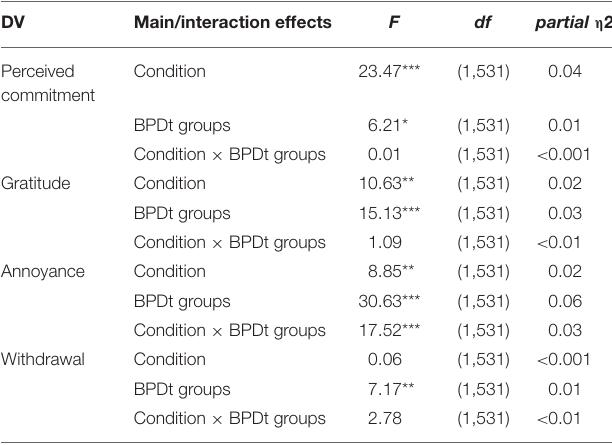
TABLE 2 | Analyses for experiment